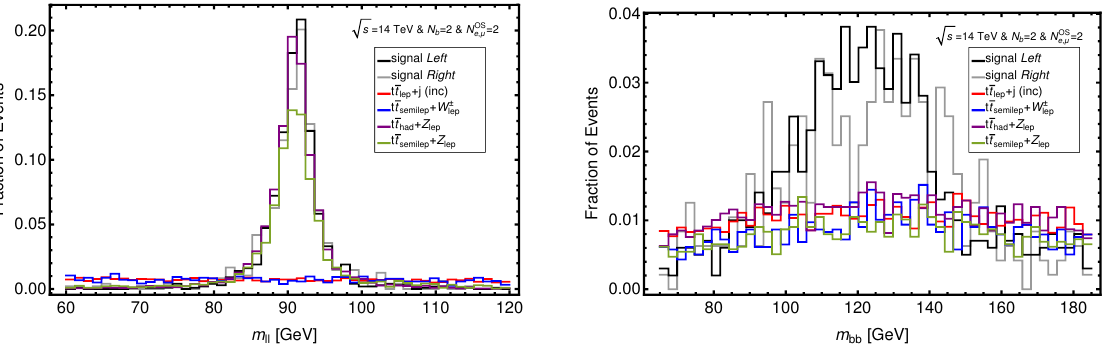
Figure 3. Distribution of missing energy E miss parton-level cuts.